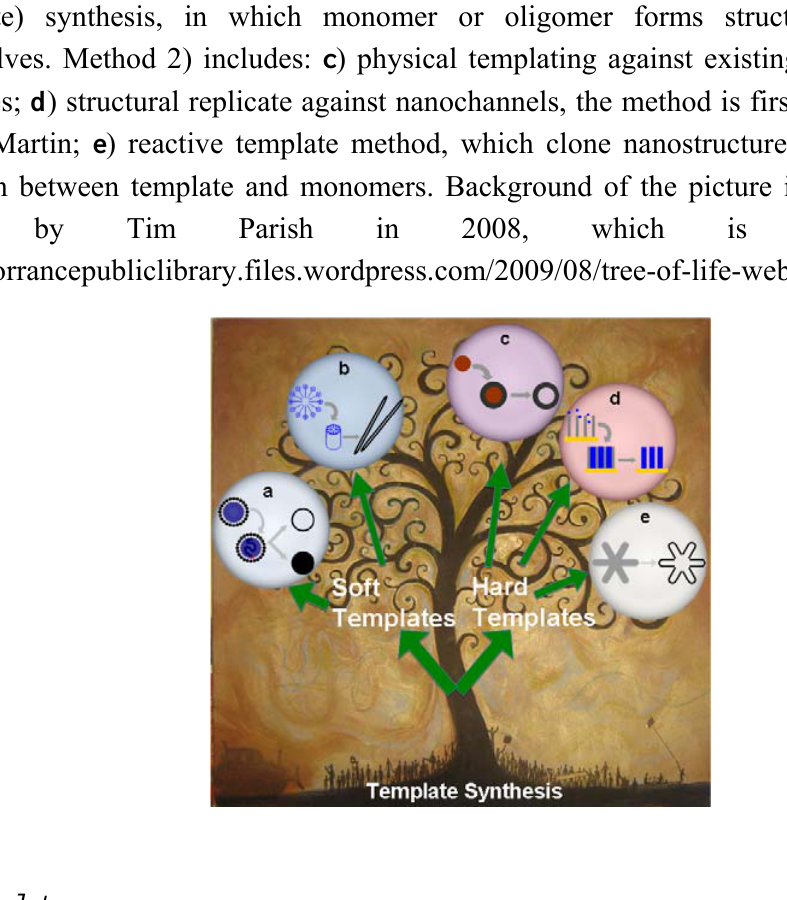
Scheme 1. Illustration of the template synthesis of conducting polymer